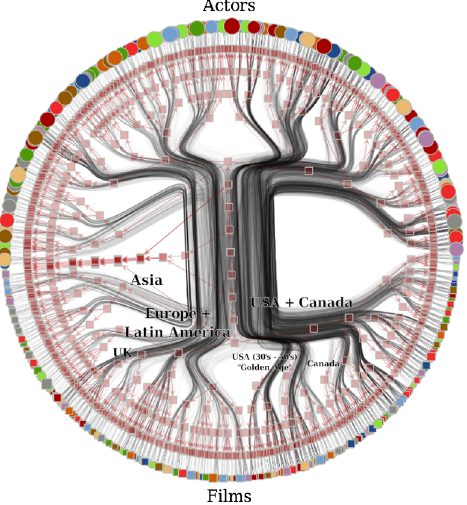
FIG. 7. Large-scale structure of the IMDB film-actor network. Each node in this graph represents a lowest-level block in the hierarchy, instead of individual nodes in the graph. The size of the nodes indicates the number of nodes in each group. The hierarchy branch at the top are the actors, and at the bottom are the films. The labels classify each branch according to the most prominent geographical and temporal characteristics found in the database. See the Supplemental Material [96] for a higher-resolution version of this